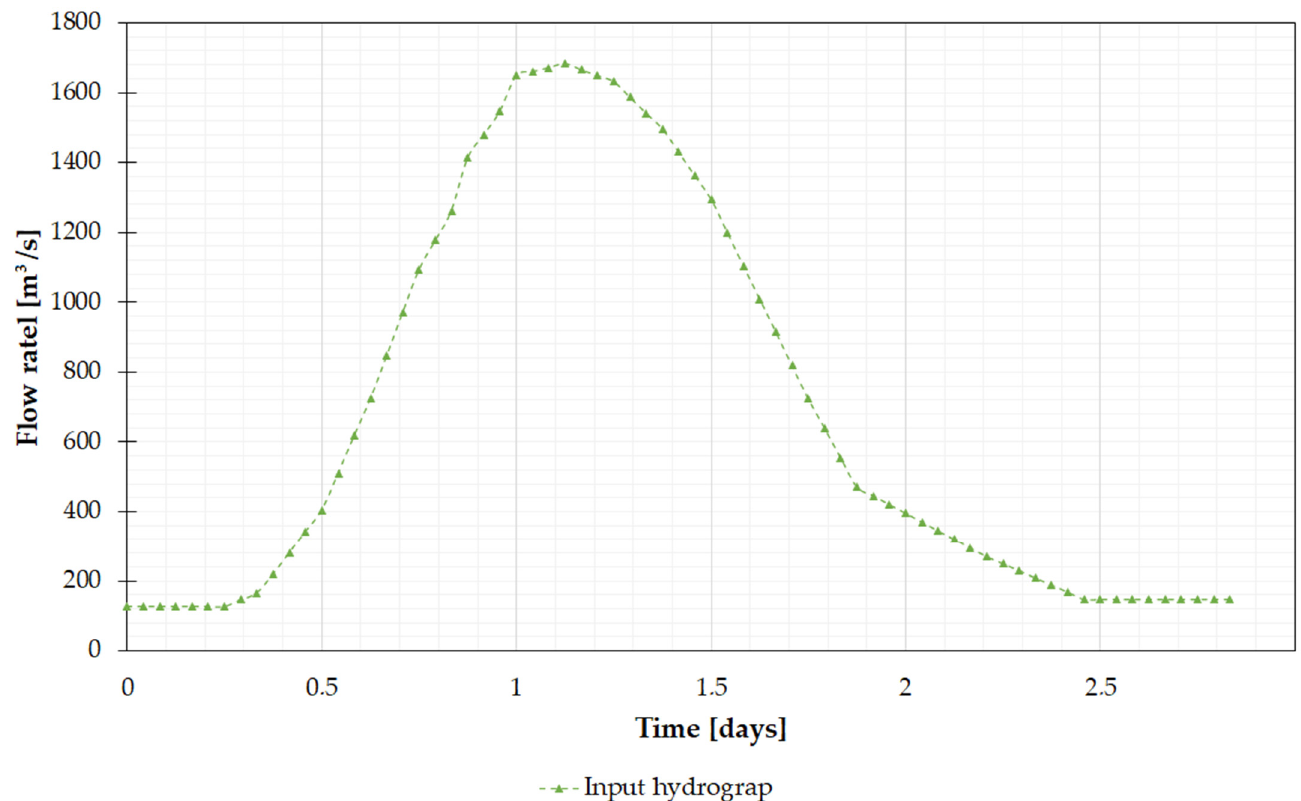
Figure 3. Design hydrograph as at boundary condition.